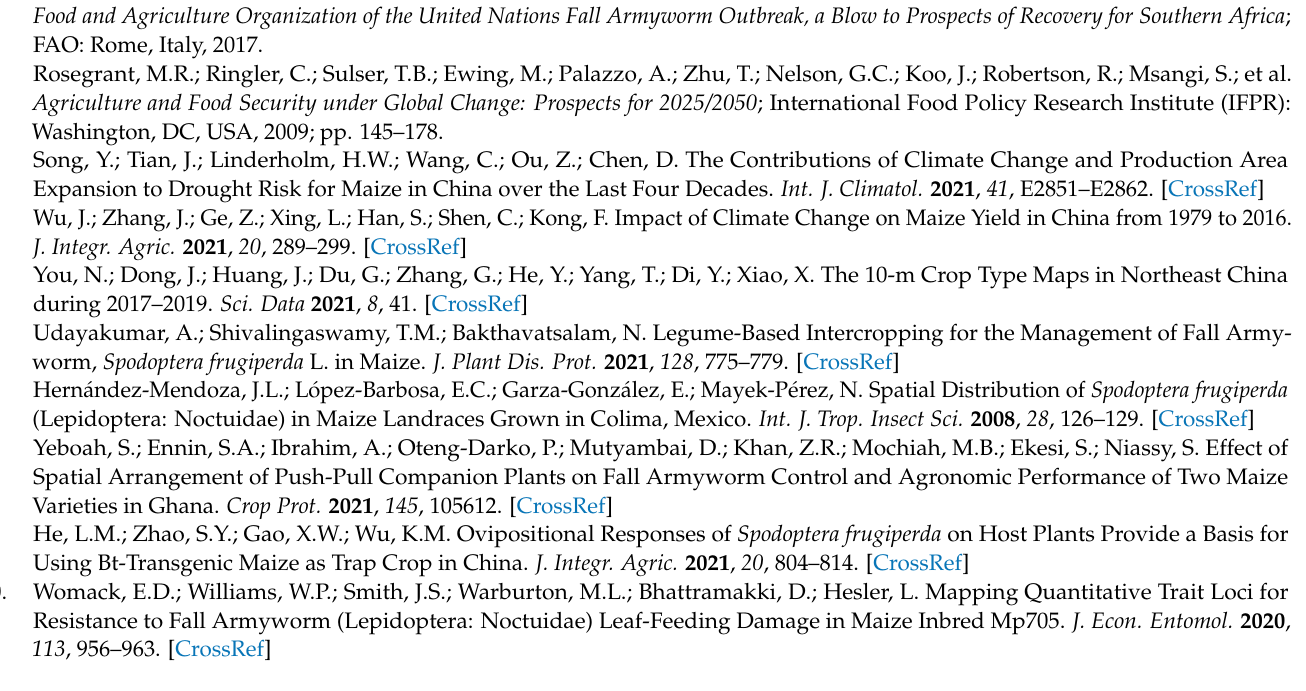
Table S4: Cumulative mortality of eggs and neonate larvae of FAW induced by B. bassiana isolates treated with 1 × 10 8 conidia/mL; Table S5: Mortality of second instar larvae of FAW infected with different concentrations of B. bassiana isolates; Table S6: Feeding efficacy of second instar larvae of FAW infected with different concentrations of B. bassiana isolates; Table S7: Mortality of pupae of FAW infected with different concentrations of B. bassiana isolates and Table S8: Analysis of variance comparison table for mean percent mortality of eggs, neonate, larvae and pupae of FAW treated with different concentrations of isolates of B. bassiana under laboratory